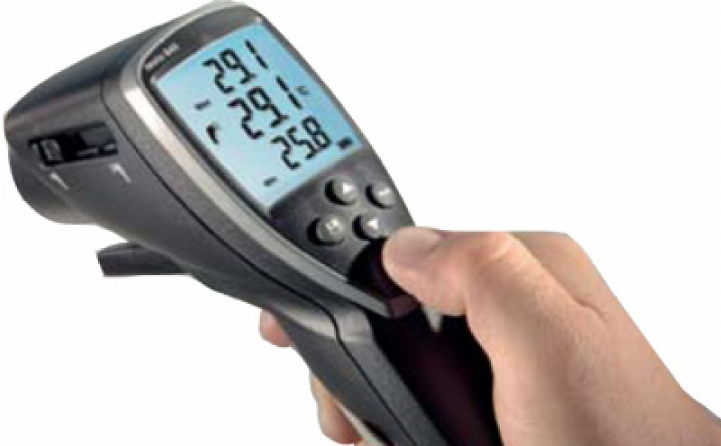
Figure 4. Testo 845 Infrared Thermometer [15,16].